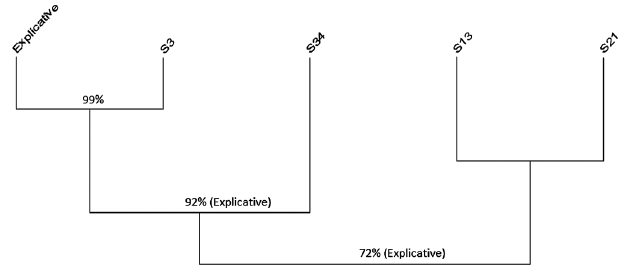
FIG. 3. Similarity tree of real students ( s i ) in relation to the explicative ideal student profile. Numbers represent the CHIC generated similarity levels between student clusters and the ideal